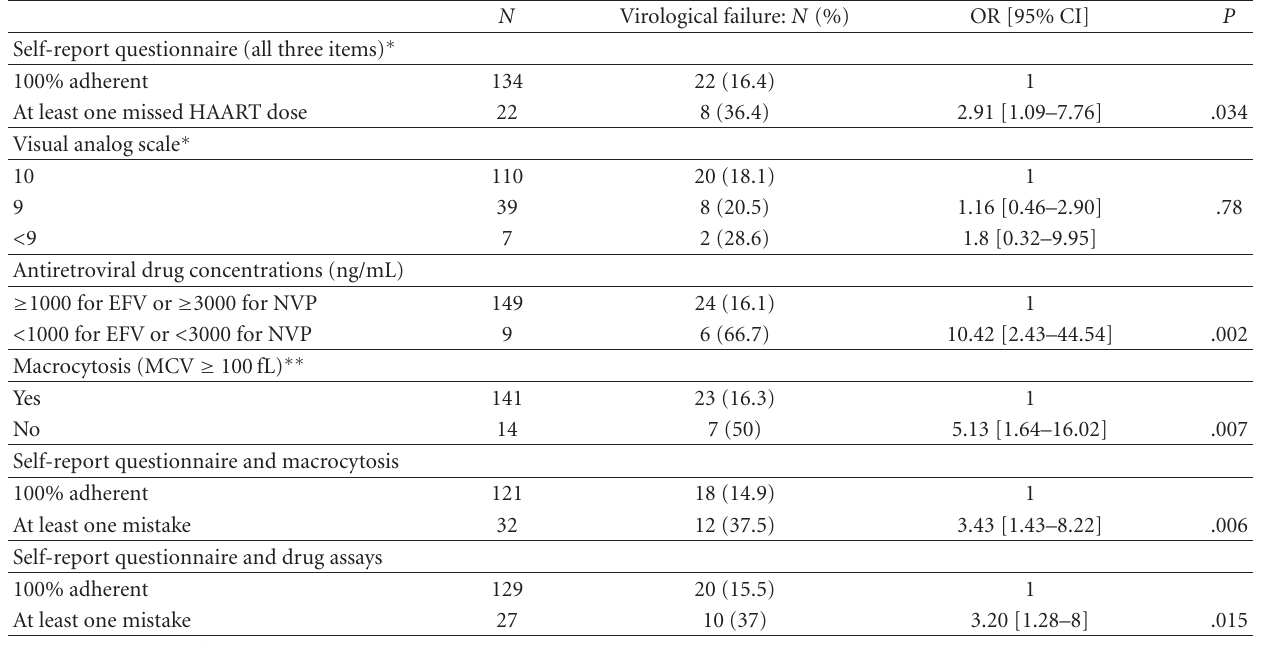
Table 3: Association between the four measures of adherence and virological failure in the previously HAART-na¨ıve population. N Virological failure: N (%) OR [95% CI] P